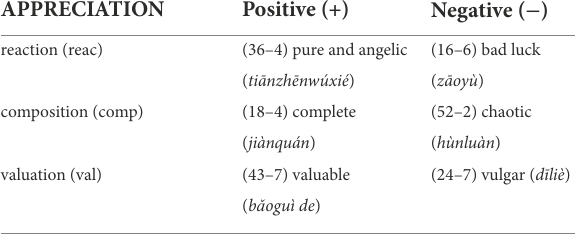
TABLE 4 Categories of appreciation 1